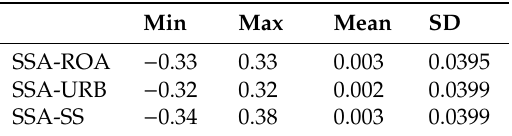
Figure6. ( a )Landslidesusceptibilitymapusingthesoilsealingaggregation(SSA)variable; ( b )Di ff erence Figure 6. ( a ) Landslide susceptibility map using the soil sealing aggregation (SSA) variable; ( b ) between SSA and ROA configurations; ( c ) di ff erence between SSA and SS configurations; ( d ) di ff erence Difference between SSA and ROA configurations; ( c ) difference between SSA and SS configurations; between SSA and URB configurations. ( d ) difference between SSA and URB configurations . Table 3. Main statistical properties of the di ff erences between the four susceptibility maps, calculated Table 3. Main statistical properties of the differences between the four susceptibility maps, calculated on a pixel-by-pixel on a pixel-by-pixel basis.